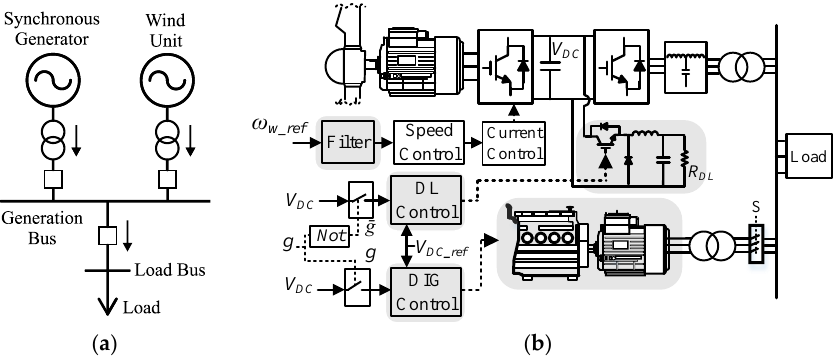
Figure 9. Diagrams of the test system: ( a ) Single line diagram of the stand-alone system; ( b ) System components with the proposed control loops.